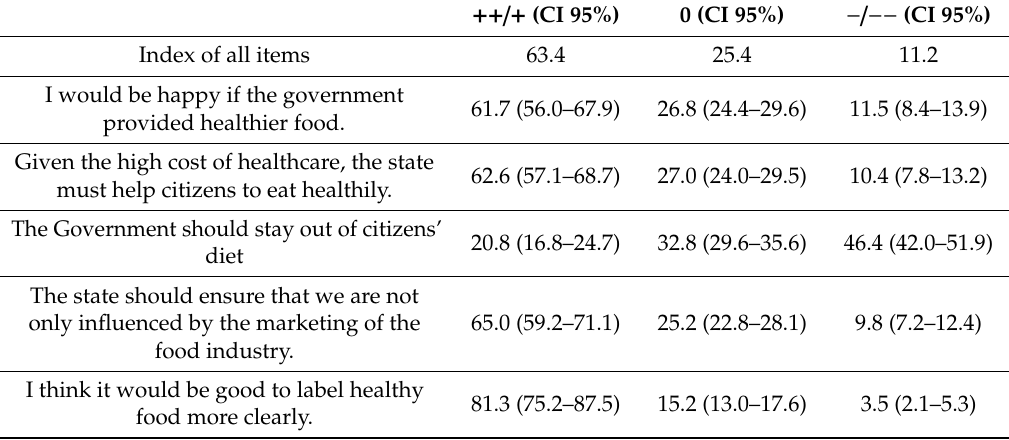
Table A1. Top box values and confidence intervals of cluster building variables.